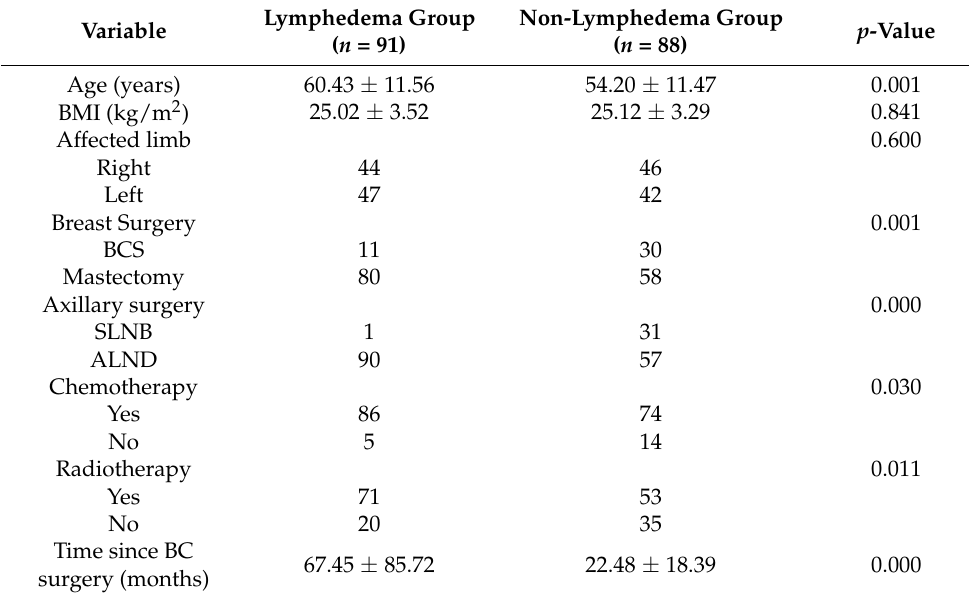
Table 1. Univariable logistic regression of participant characteristics.